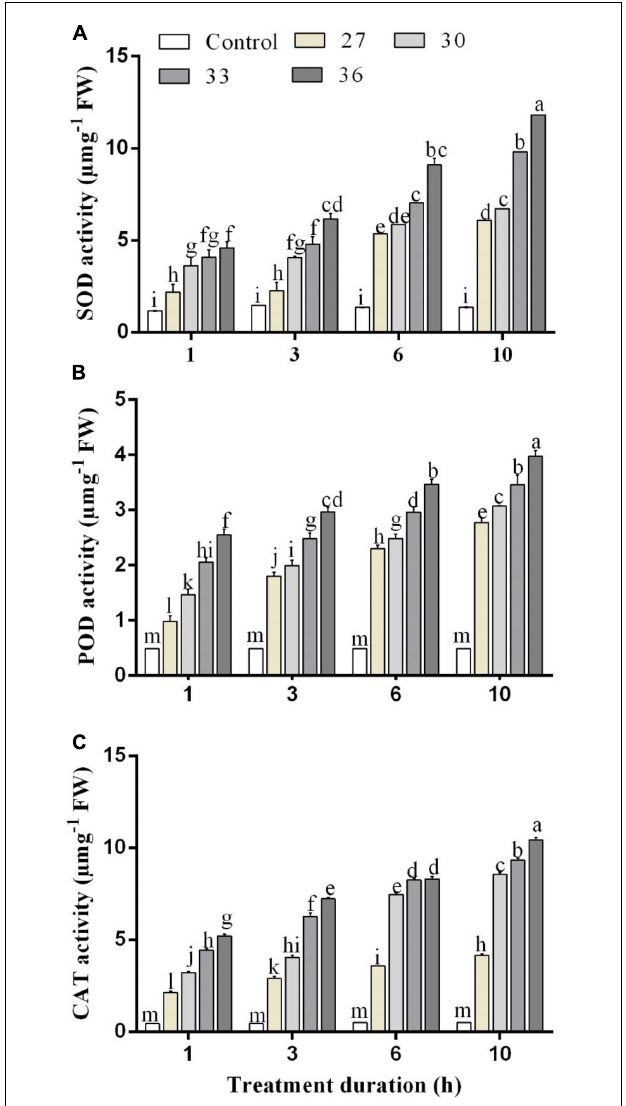
FIGURE 1 | (A) Superoxide dismutase (SOD), (B) peroxidase (POD), and (C) catalase (CAT) activity in M. persicae under different heat stresses (27, 30, 33, and 36 ◦ C) at different durations (1, 3, 6, and 10 h) in growth chambers. Small bars represent the standard errors of the means. Different lower case letters indicate significant differences between treatments at Tukey’s HSD test ( p < 0.05) using one-way ANOVA. FW is the fresh weight of